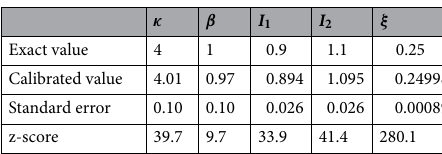
Table 2. Calibrated results for the case of two alternatives.